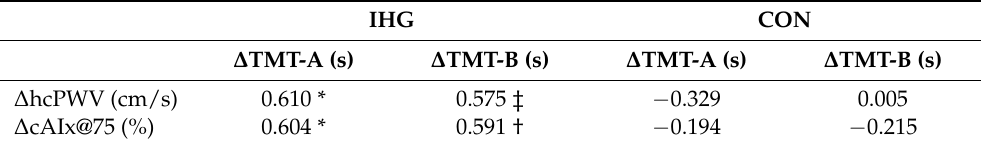
Table 3. Correlation coefficients between ∆ TMT-A and ∆ TMT-B as well as between ∆ hcPWV and ∆ cAIx@75.